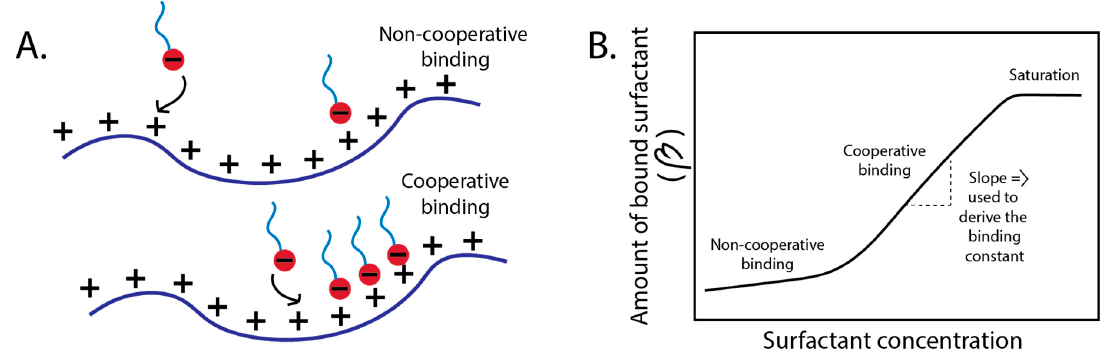
Figure 4. ( A ) Non-cooperative and cooperative binding of surfactant to polyelectrolyte ( B ) Illustration of the binding isotherm: degree of binding ( β ) versus surfactant concentration.